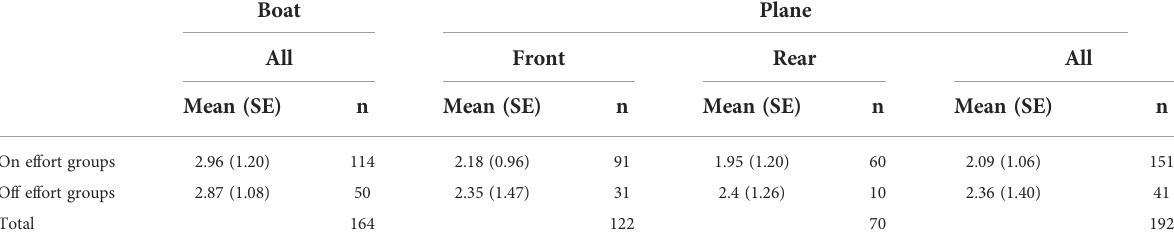
TABLE 2 Summary of mean (standard error, SE, in parenthesis) group sizes of franciscana dolphins recorded from two different platform types in Babitonga Bay, southern Brazil, in February 2011.